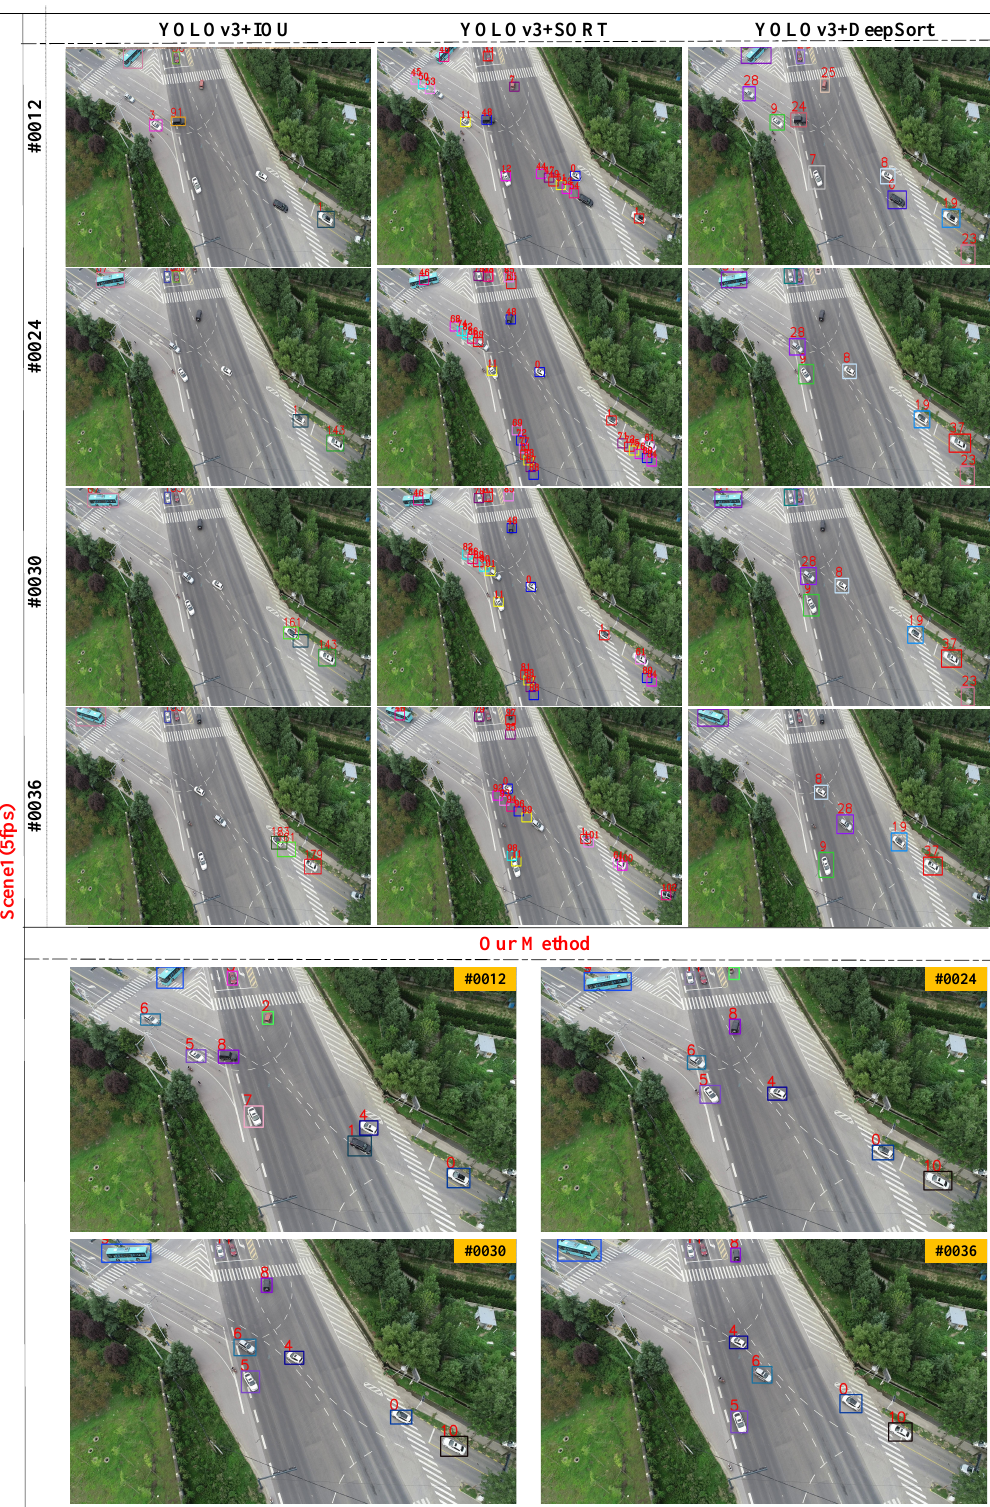
Figure 10. Tacking results of this algorithm and three other tracking algorithms, YOLOv3 + IOU, YOLOv3 + SORT, and YOLOv3 + DeepSort, in Scene 1. Scene 1 was an intersection with a complex background and vehicle movement, and the video frame rate of the experimental images was 5